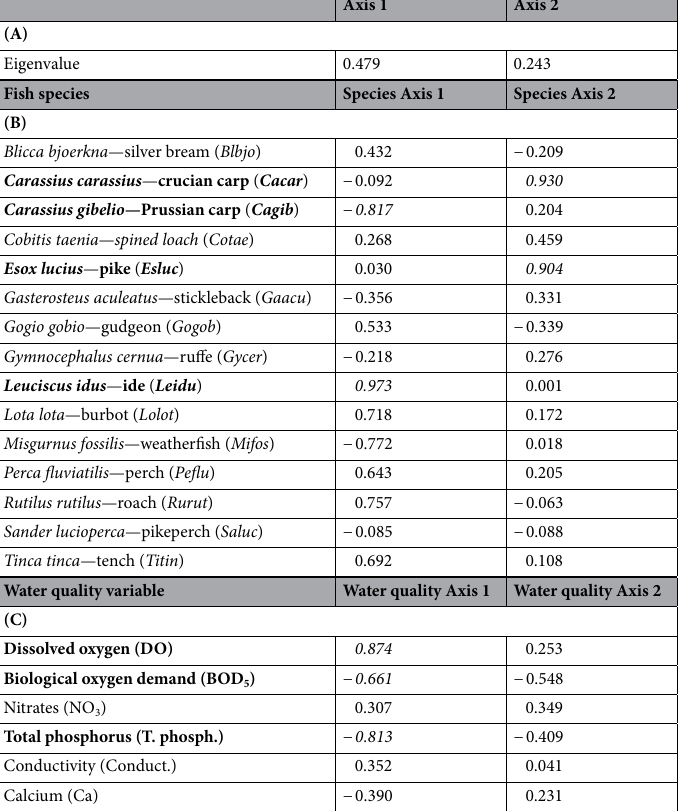
Table 4. Results of RDA analysis of the relations between fish biomass and water quality variables. Abbreviations of fish species names that are used in the RDA figure are given in brackets. Statistically significant variables are in bold font. The respective values of significant variables are in italic font. (A)—Variability of fish species biomass (in shares of unity) explained by given canonical axis. (B)—Correlations between the biomass of given fish species and the canonical axes representing species. (C)—Correlations between water quality variables and canonical axes representing water quality